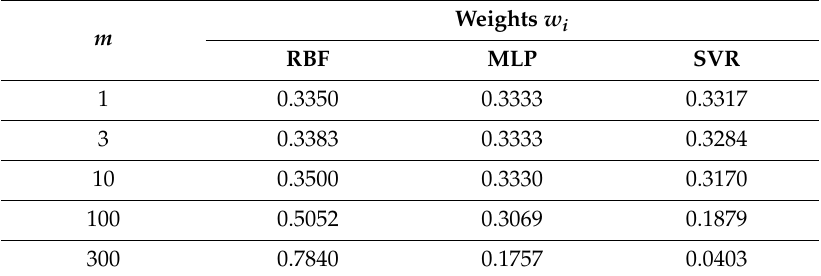
Table 5. Weights were obtained based on a Formula (3) using di ff erent values of m .